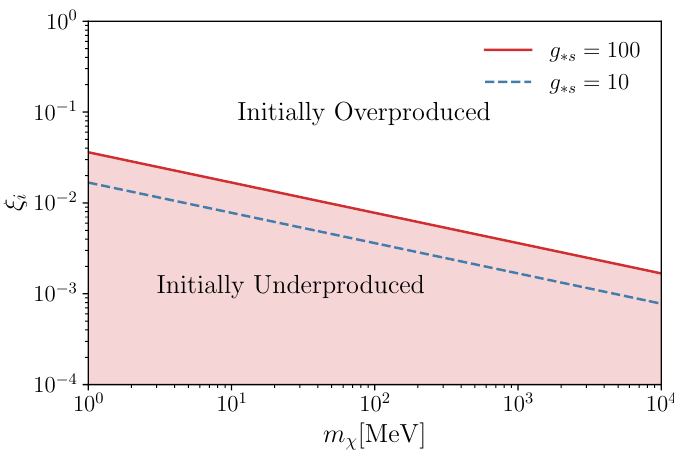
Figure 3 . Initial DM density as a function of the initial hidden-to-SM temperature ratio ξ i and DM mass m . The boundary between initial overproduction and initial underproduction (which χ depends on g ) defines the parameter space for which the freeze-out or freeze-in mechanisms are ∗ s